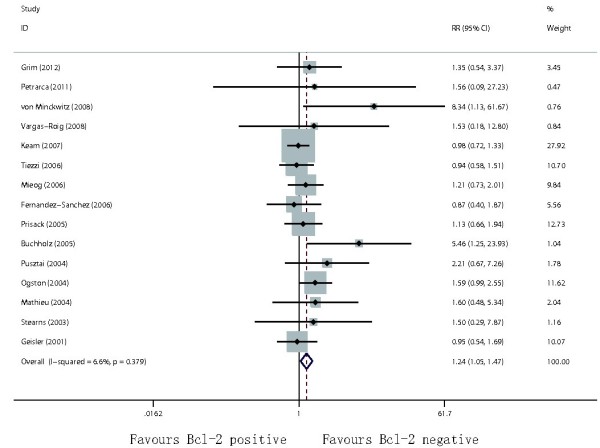
Forest plots of RR were assessed for the evaluation of total OR in anthracycline-based settings.